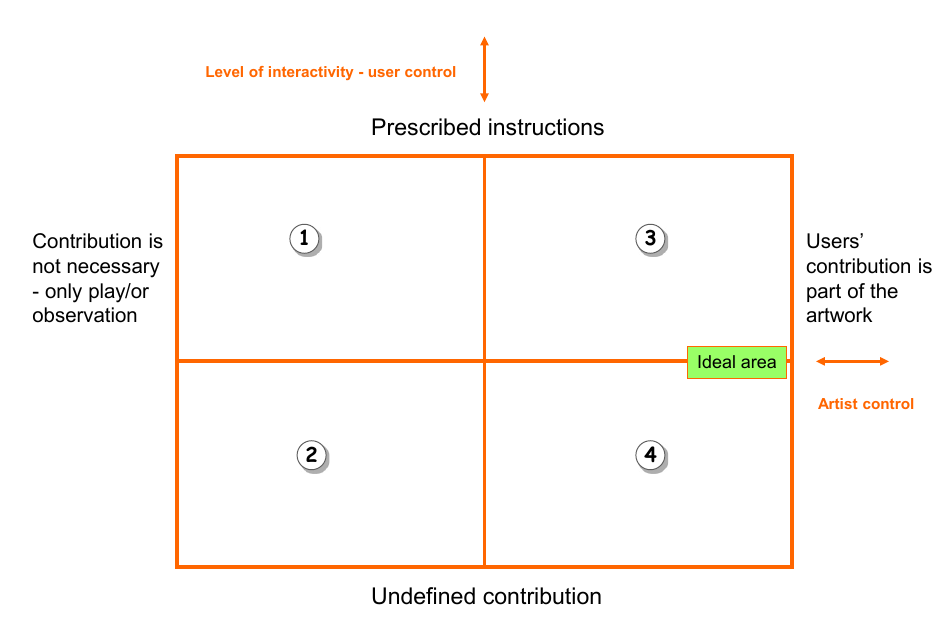
Figure 1. “Interactive space” visualization (Kawka,